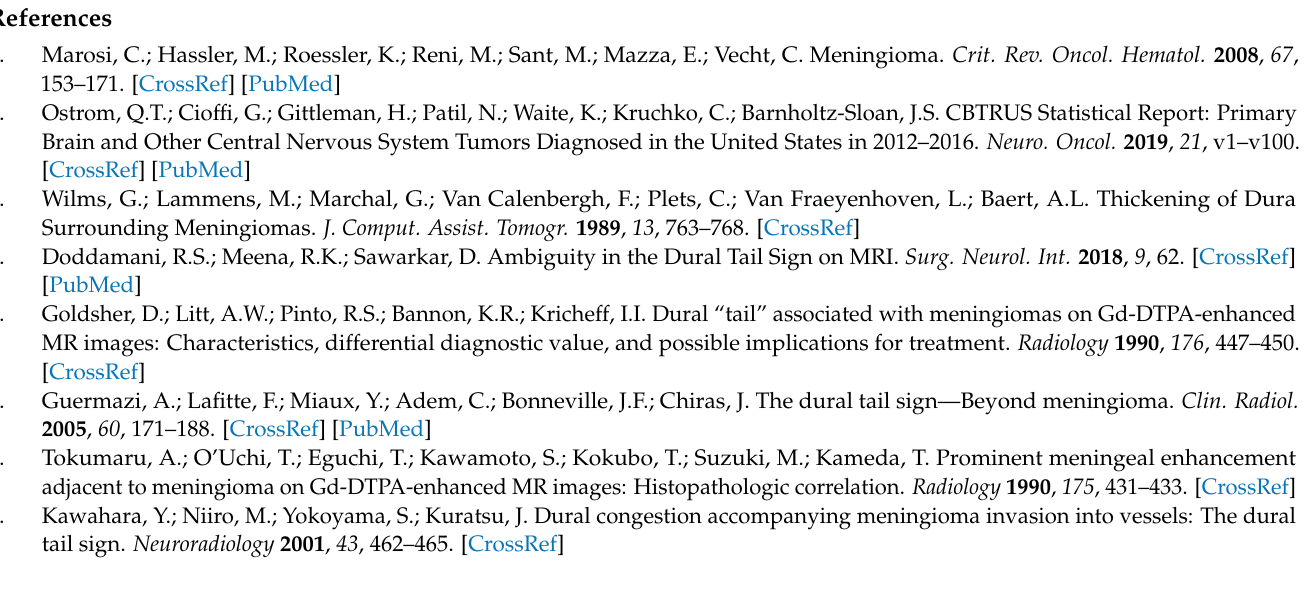
Table S2: Characteristics used for the radiomic analysis of the dural